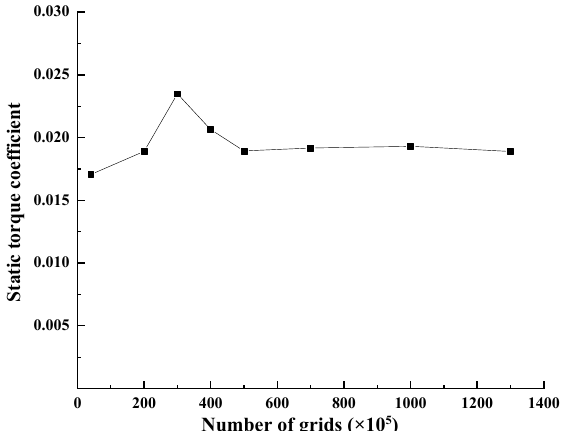
Figure 4. Static torque coefficient of spiral Savonius wind turbine in different grid numbers (α = 0°).